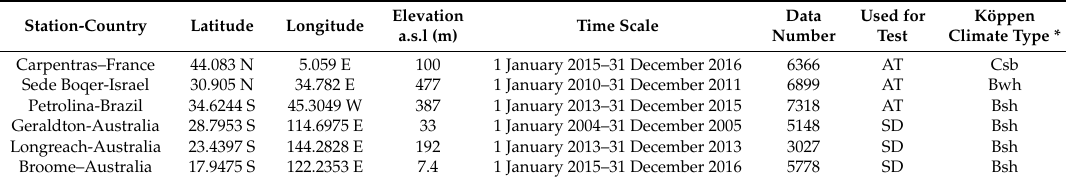
Table 3. Description of processed data of hourly GHI, DNI and Diffuse Horizontal Irradiance (DHI) measured by Kipp and Zonen equipment with high quality for six stations elsewhere in the world for